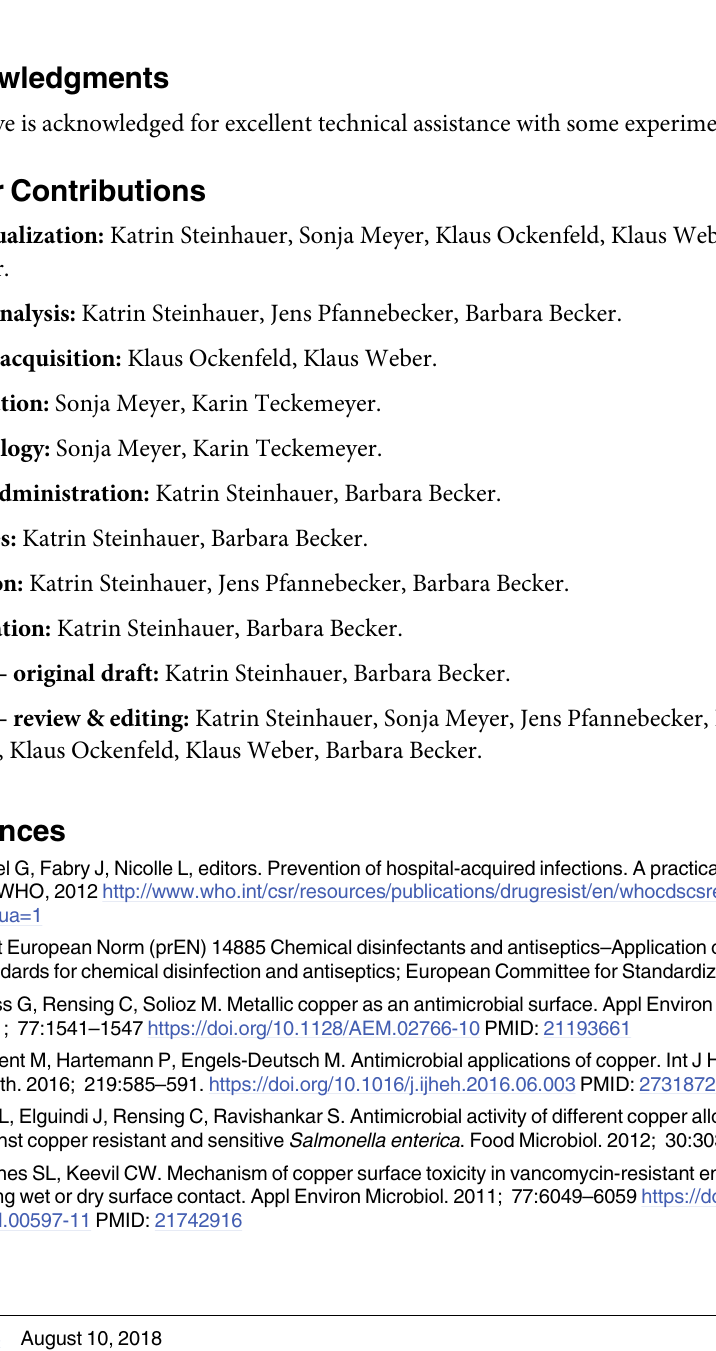
S1 Fig. Illustration of experimental design for data presented in Figs 1 and 2A. S2 Fig. Illustration of experimental design for data presented in Fig 2B. S3 Fig. Illustration of experimental design for data presented in Figs 3 and